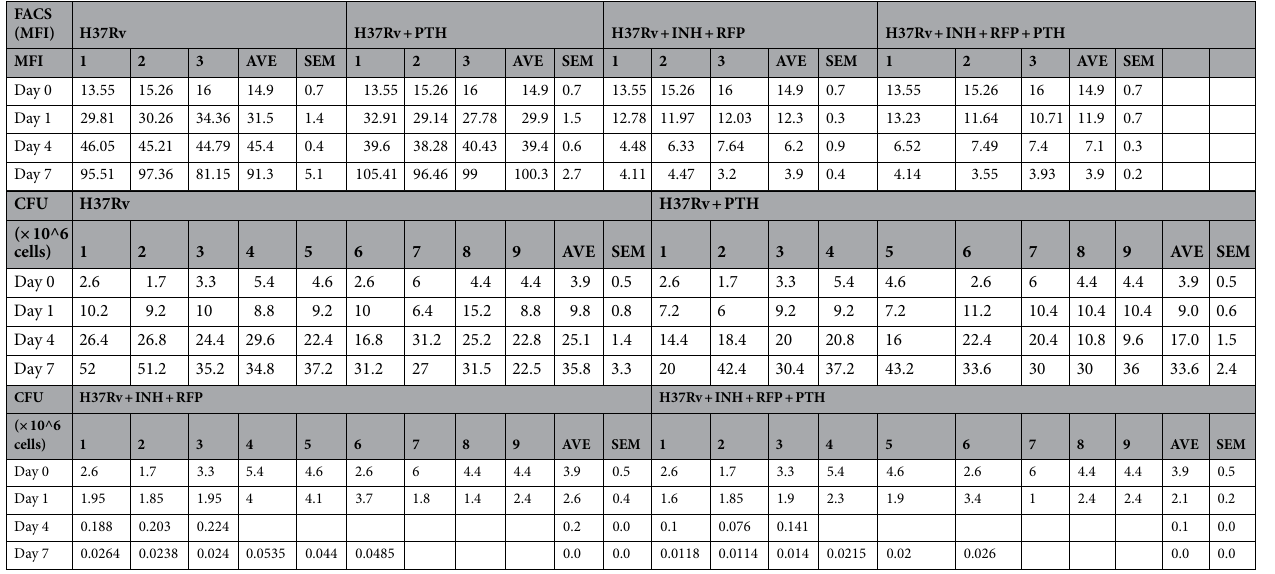
Table 1. Mean fluorescence intensity (MFI) and colony-forming units (CFU)